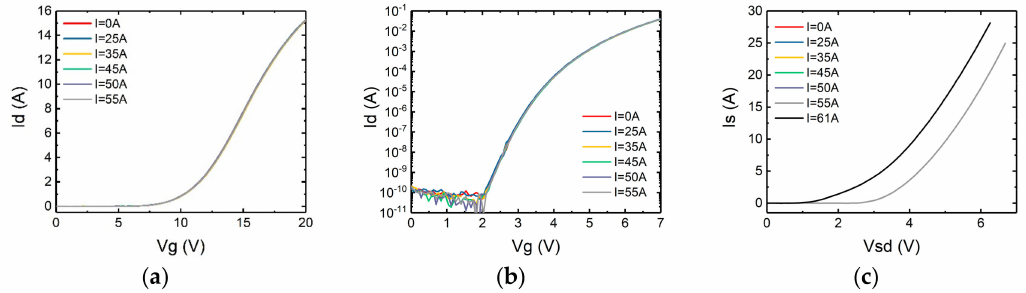
Figure 8. ( a ) Transfer characteristics, ( b ) sub-threshold swing characteristics, ( c ) forward conduction characteristics of the body diode of SCT10N120 after each surge test.